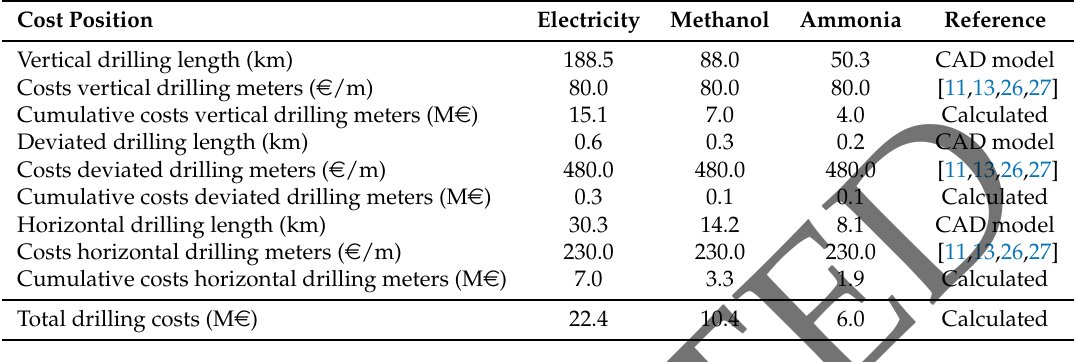
Table 3. Calculated drilling meters and resulting costs for injection and production wells in the onshore electricity, methanol and ammonia production scenarios.